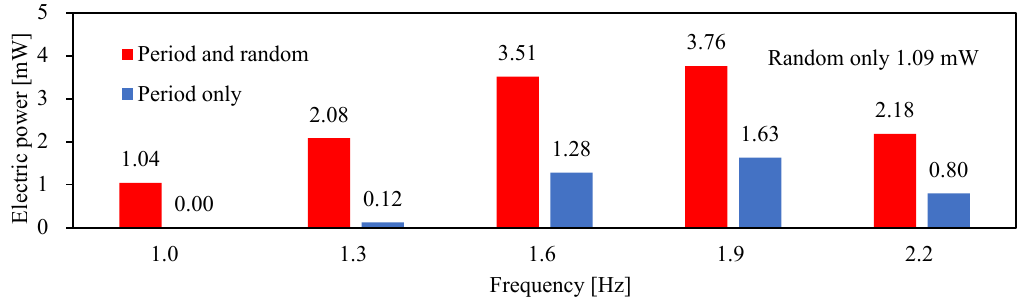
Figure 23. Comparison of S.D. displacements of random and period excitation.